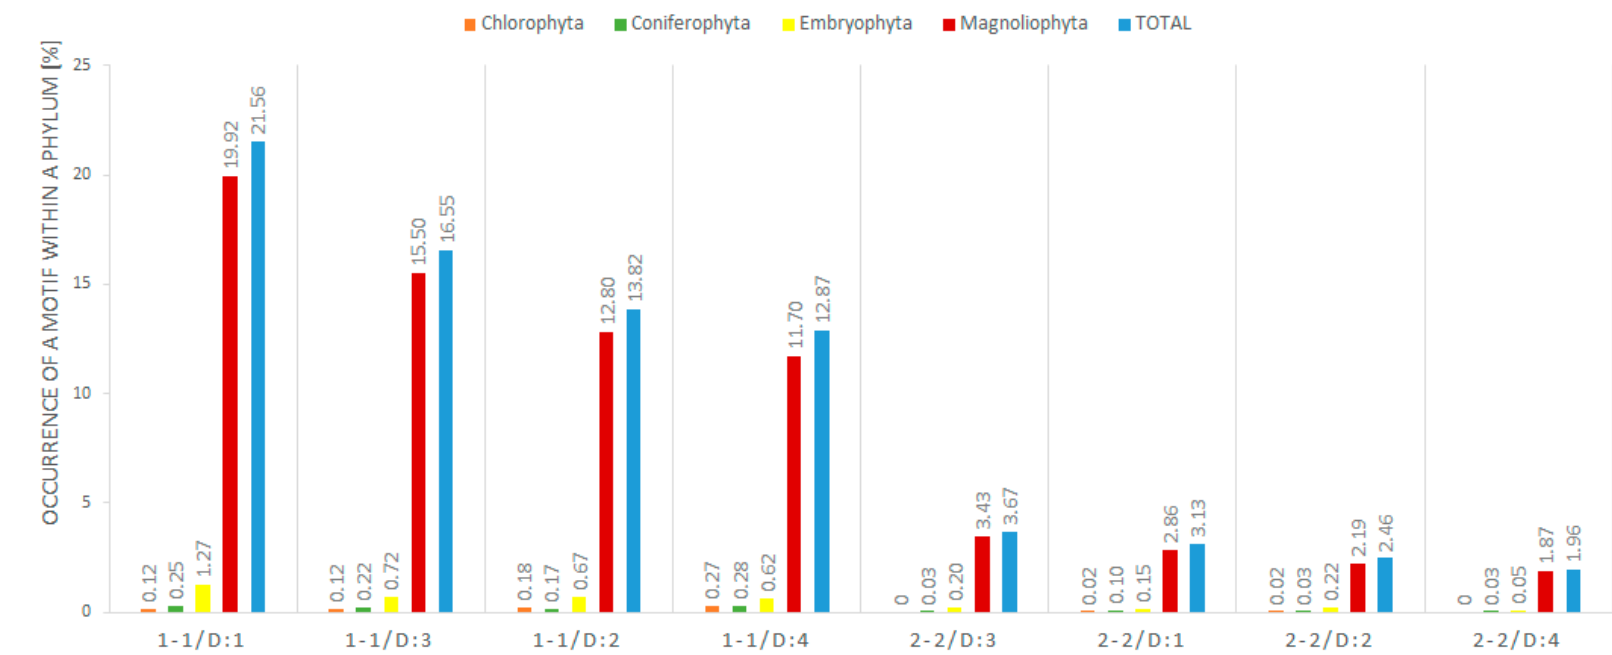
Figure 3. Distribution of eight most-occurring two-dimensional (2D) motifs in 5975 structures by phyla. The results are arranged from the least frequent motif to the most common one.